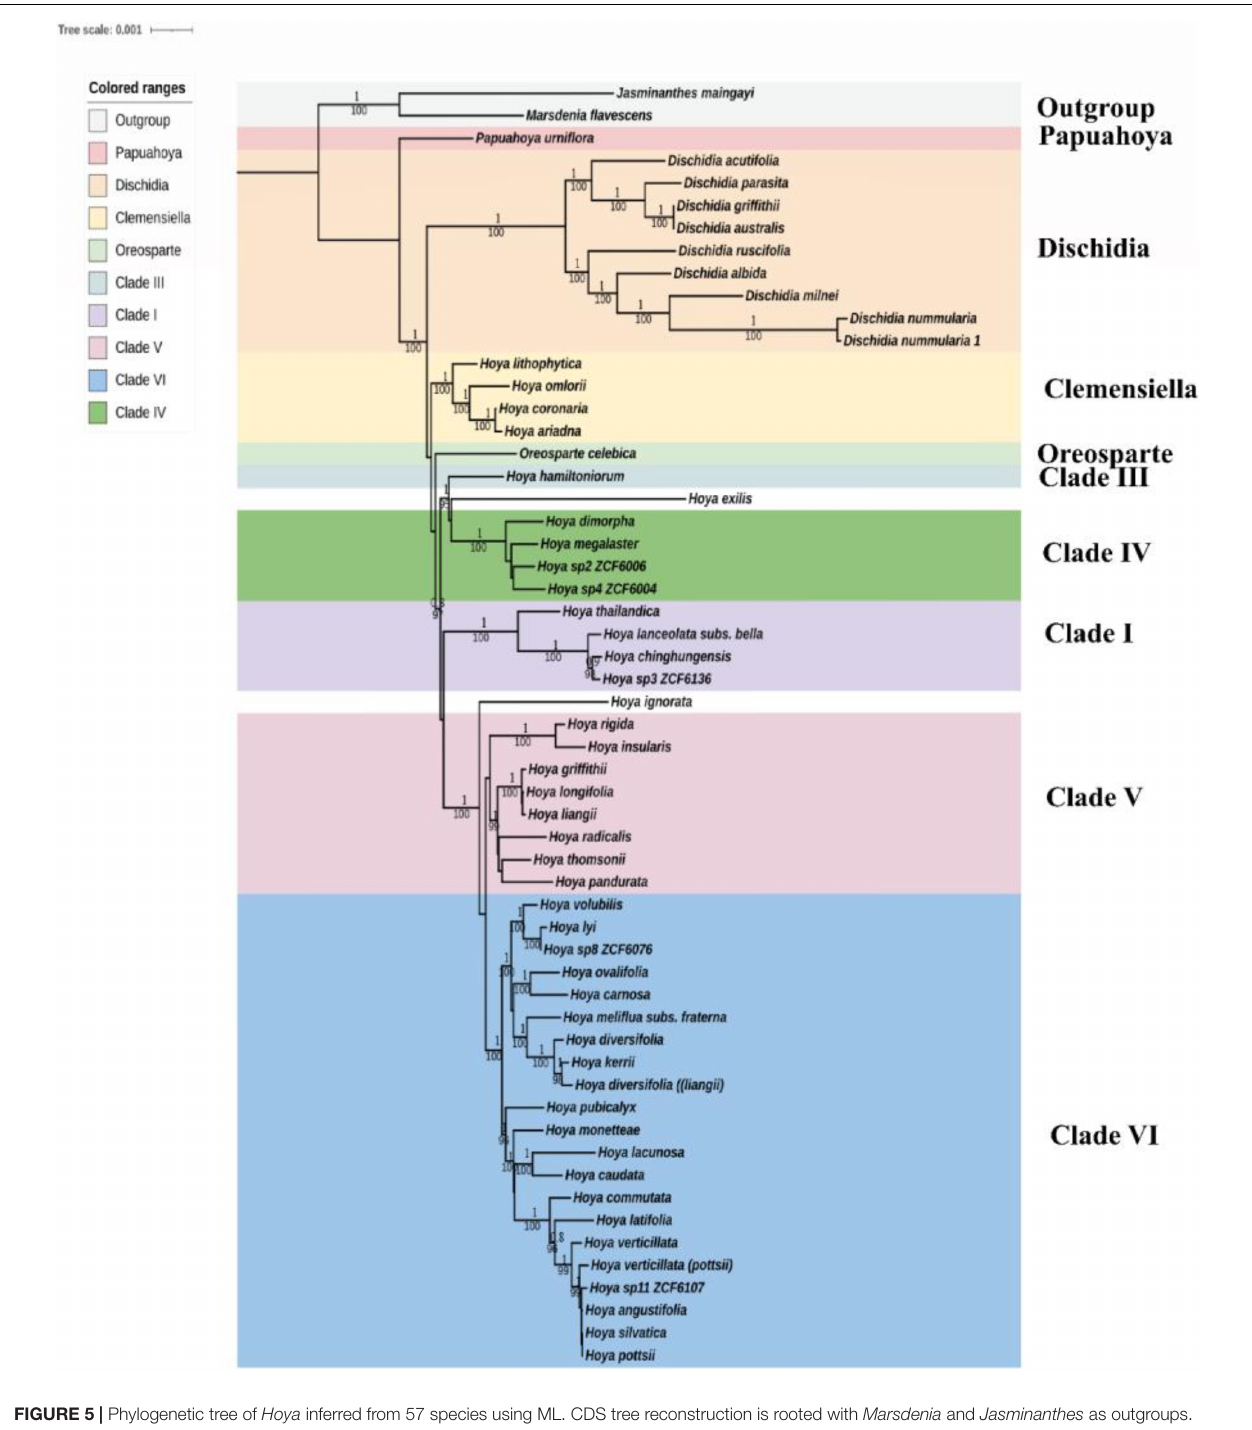
polymorphism, and co-dominance (Ivanovych and Volkov, 2018). In a previous study, Straub et al. (2011) focused only on the repeat sequences based on the nuclear genome. Similar to most